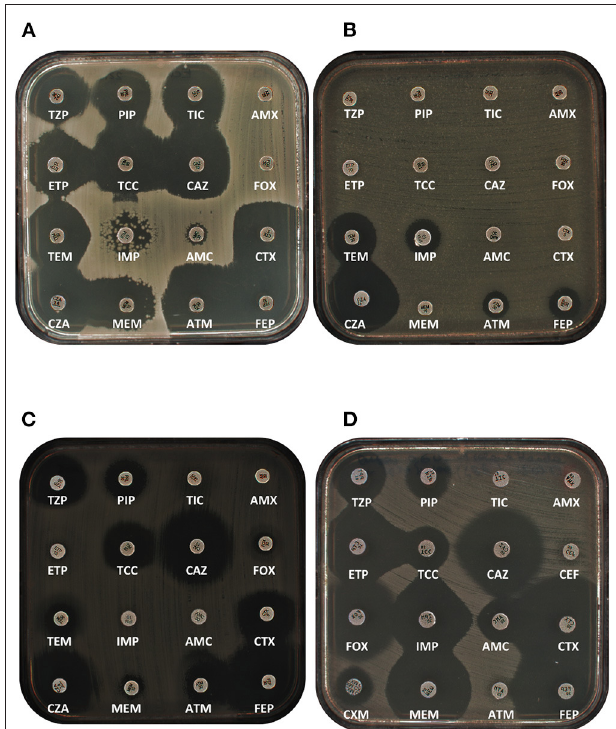
FIGURE 1 | Antibiograms of representative class A carbapenemases. (A) IMI-1-producing E. cloacae complex clinical isolate. (B) GES-5 producing K. pneumoniae clinical isolate. (C) SME-3-producing S. marcescens . (D) FRI-1-producing E. coli transformant. AMX, Amoxicillin; AMC, Amoxicillin/clavulanate; ATM, aztreonam; CAZ, ceftazidime; CTX, Cefotaxime; CZA, Ceftazidime/avibactam; ETP, Ertapenem; FEP, Cefepime; FOX, Cefoxitine; IPM, Imipenem; MEM, Meropenem; PIP, Piperacillin; TCC, Ticarcillin/Clavulanate; TEM, Temocillin; TIC, Ticarcillin; TZP,